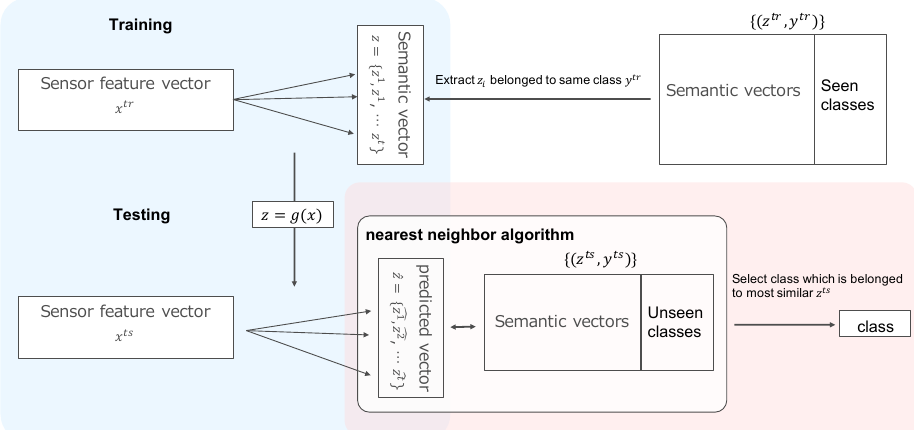
Figure 2. Overview of the zero-shot learning method. The top show the trainig phase and the bottom show the testing phase. The blue part shows the projection phase, and the red part shows the classification